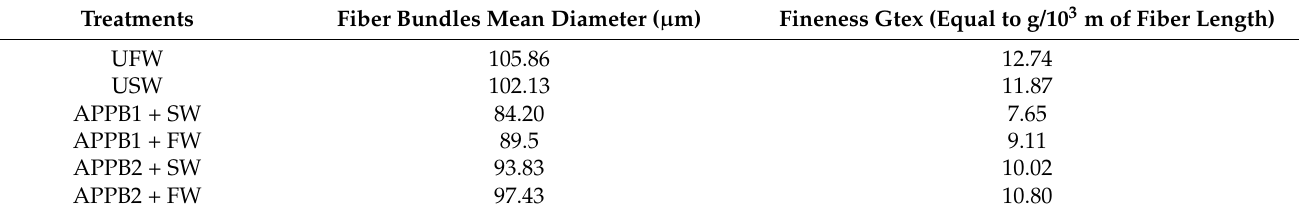
Table 3. Fiber diameter and fineness of the retted kenaf